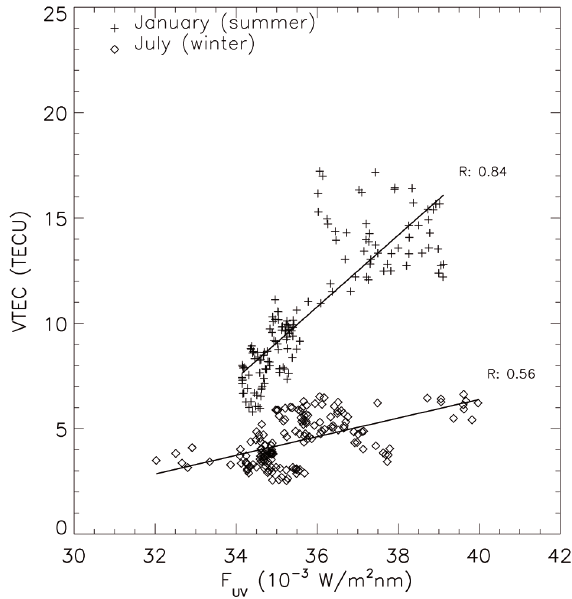
Figure 3. Variations of the 3-day smoothed daily maximum VTEC for January (summer) and July (winter) with respect to the solar F intensity used as a proxy for the solar activity. Both datasets were fitted with linear regression (R, correlation